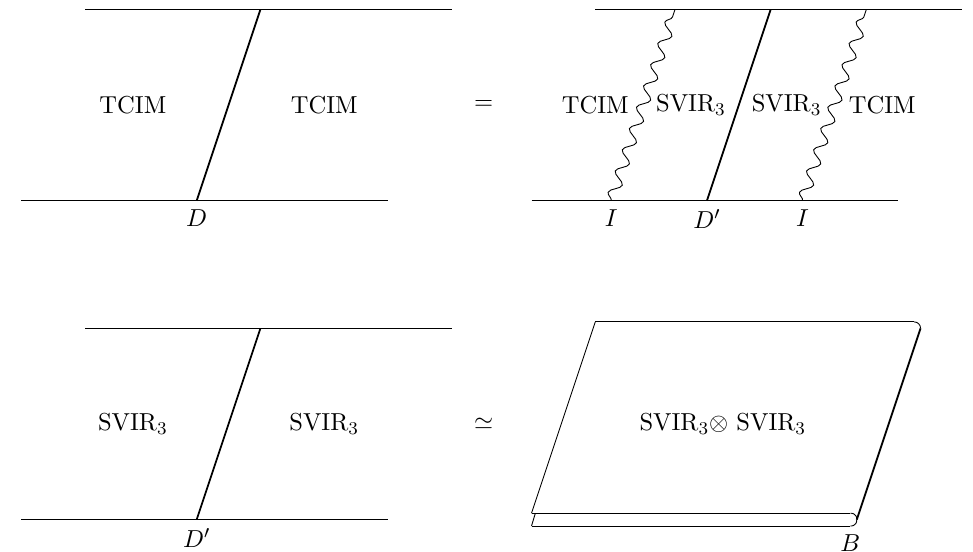
Figure 1 . The equivalence between a boundary condition B in the folded fermionic model, a defect D 0 in the fermionic model and a defect D in the TCIM. I is an interface